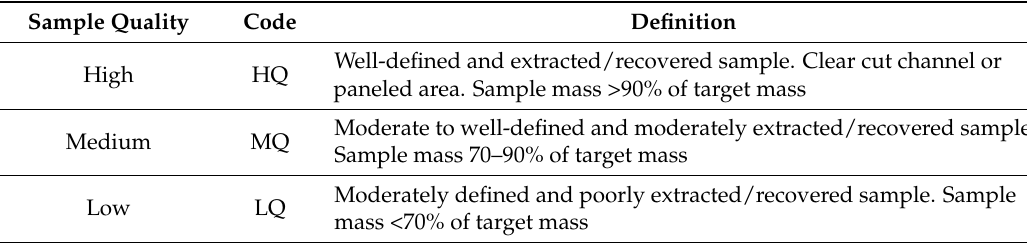
Table 14. Sample quality rating as applied at the Gwynfynydd mine. Rating applied to both chip-channel 1 and panel 2 samples.